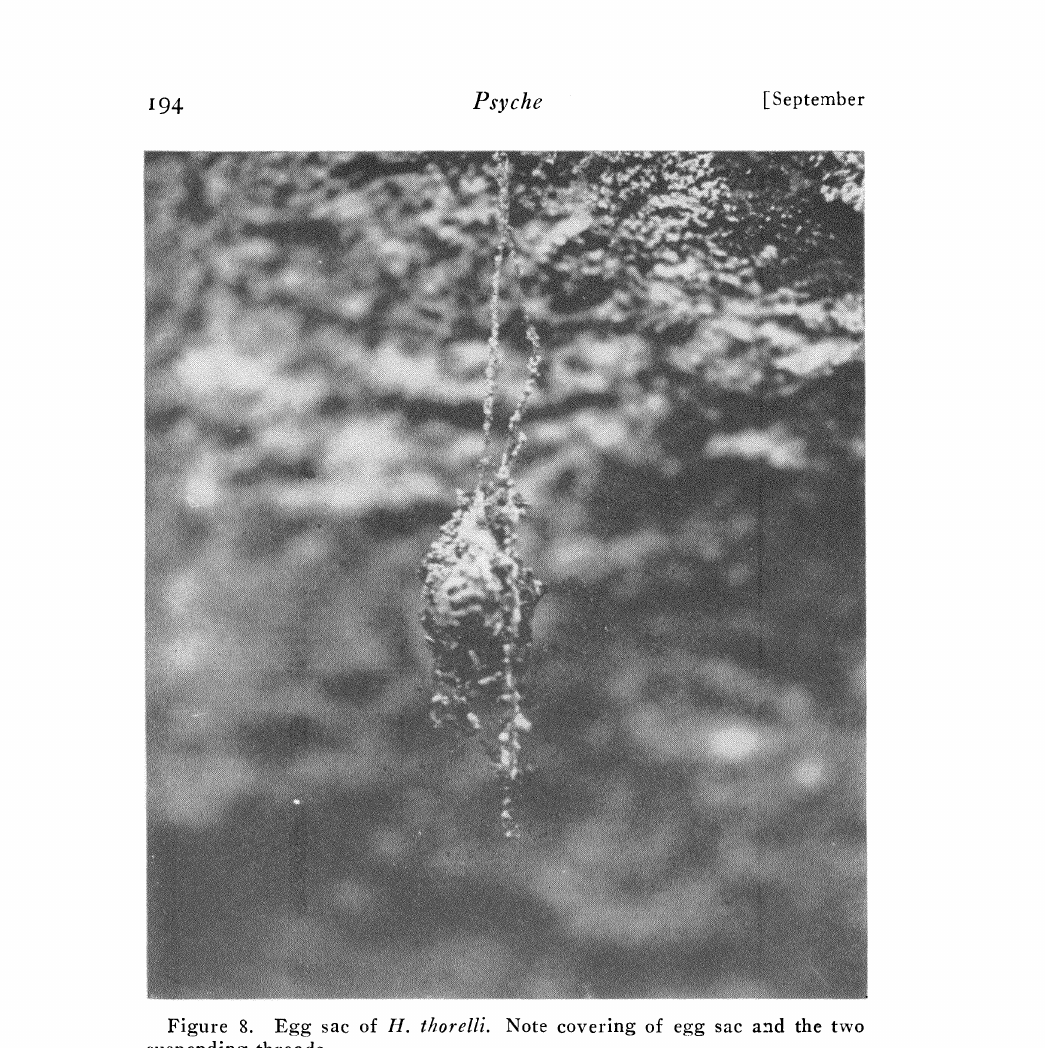
Figure 8. Egg sac of H. thorelli. Note covering of egg sac and the two suspending